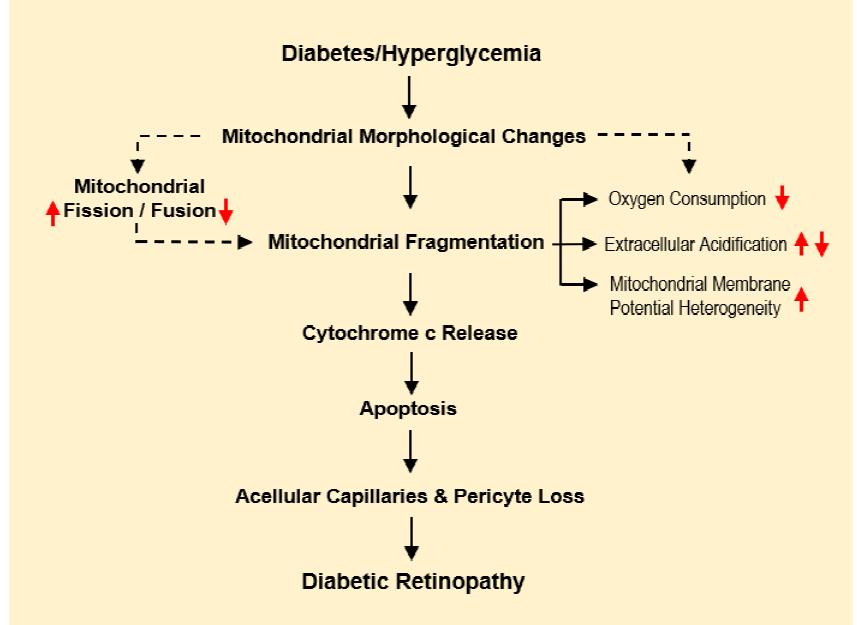
Figure 1. Changes in mitochondrial morphology and its implications in diabetic retinopathy. Diagram illustrates the effects of diabetes/hyperglycemia on mitochondrial morphology changes leading to mitochondrial dysfunction, contributing to the development and progression of diabetic retinopathy. Dashed arrows suggest possible mechanisms that are still under investigation.